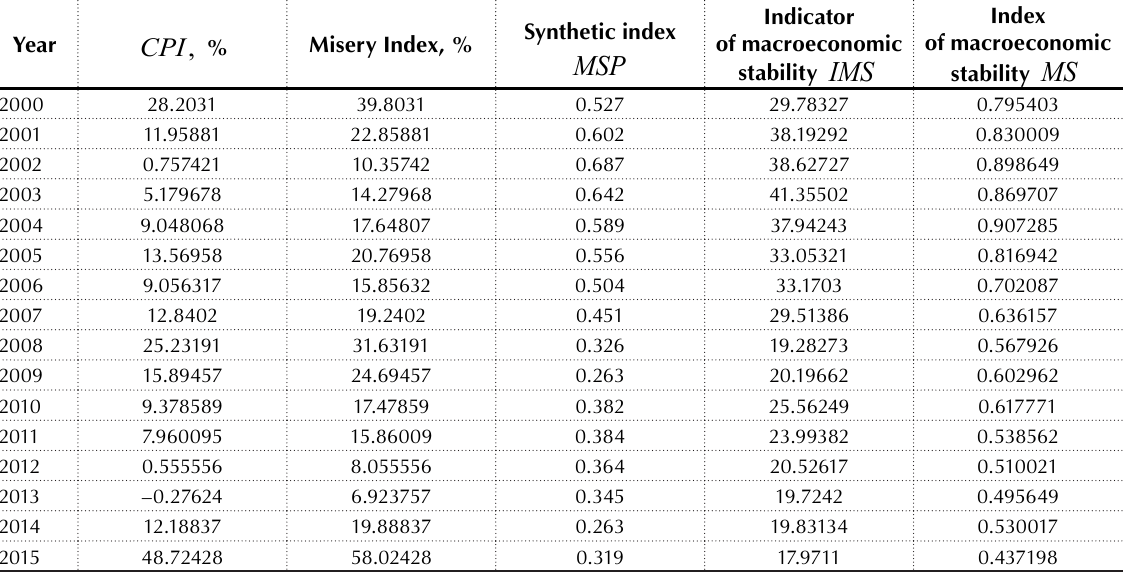
Table 1. Calculation of macroeconomic stability of Ukraine over the period 2000–2015 (our own calculations based on data